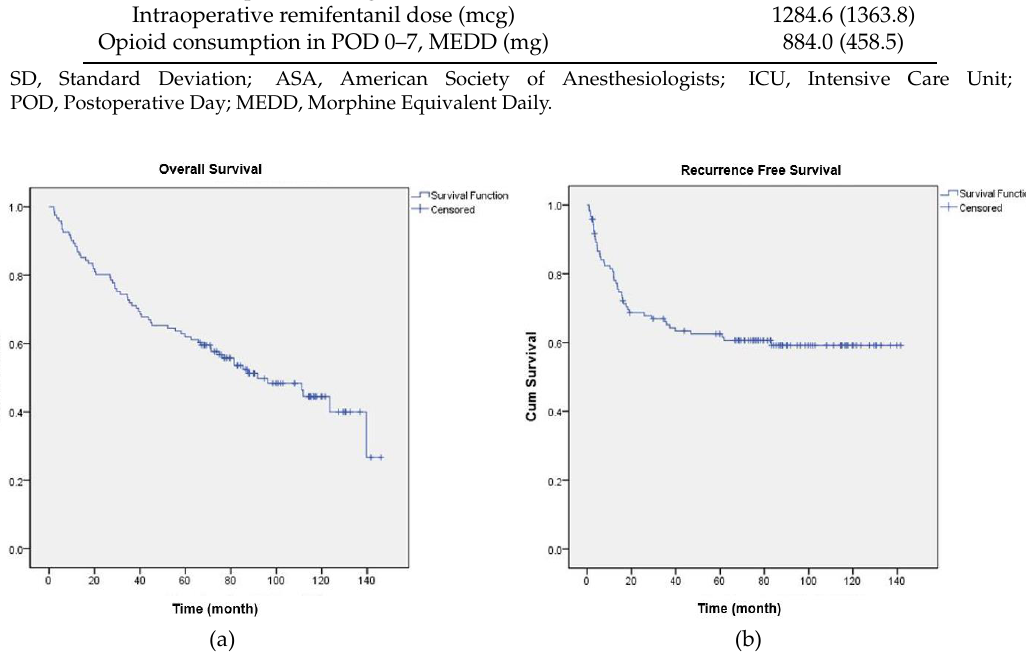
Figure 1. (a) Overall survival of all patients, mean (months): 7.2, SD 0.4, 95% confidence